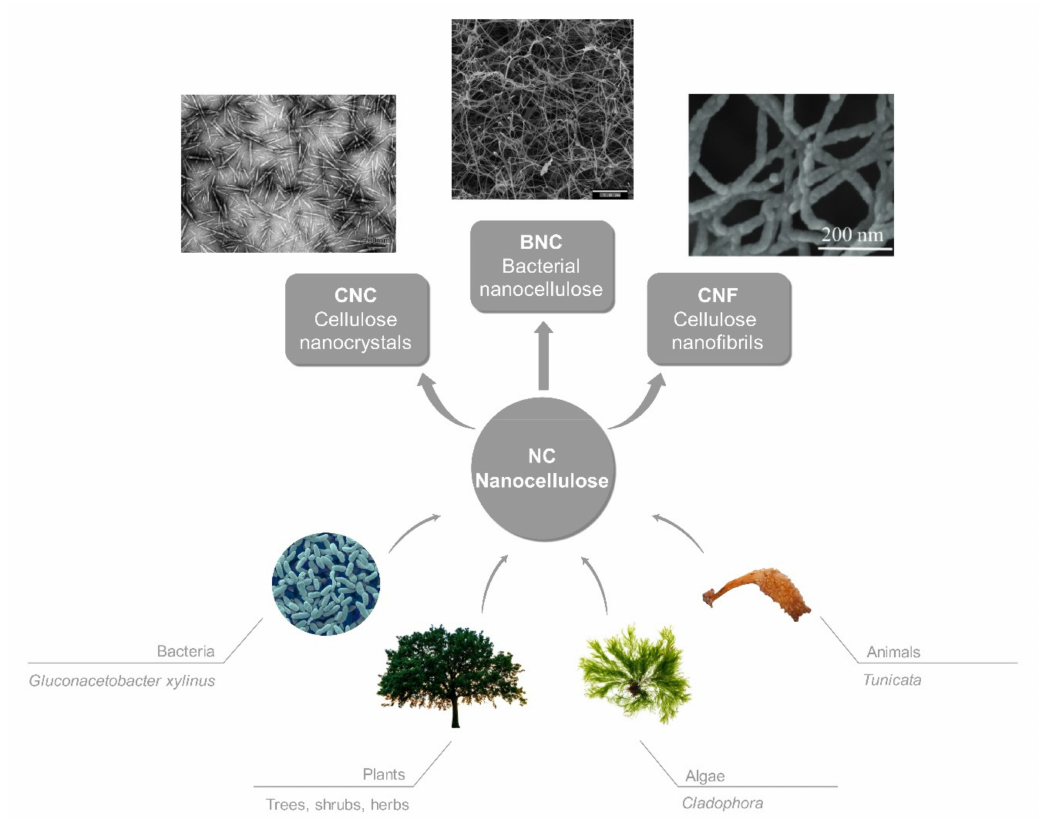
Figure 2. Di ff erent sources and types of nanocellulose with representative electron microscope images [8–10], reproduced by permission of The Royal Society of Chemistry